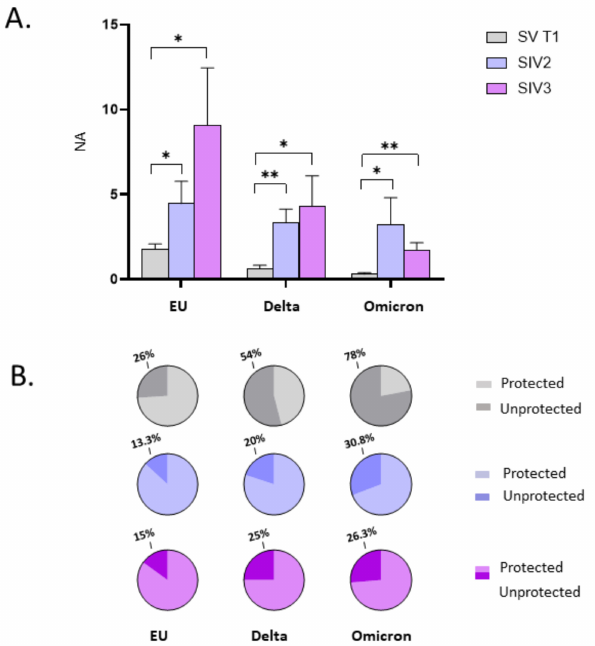
Figure 8. Comparison of neutralizing activity (NA) in saliva specimens from SARS-CoV-2 Infected after 2 (SIV2), or 3 doses of Vaccine (SIV3) and SARS-CoV-2 Vaccinated subjects (SV) at T1. NA against the EU, Delta, and Omicron variants in saliva samples from SIV2 and SIV3 was higher in comparison to SV samples at T1 ( A ). Pie charts show the percentage of SV (grey), SIV2 (light blue), and SIV3 (lilac) lacking salivary NA against the EU, Delta and Omicron variants, respectively ( B ). Mean values ± SE are reported. * p < 0.05, ** p < 0.01.